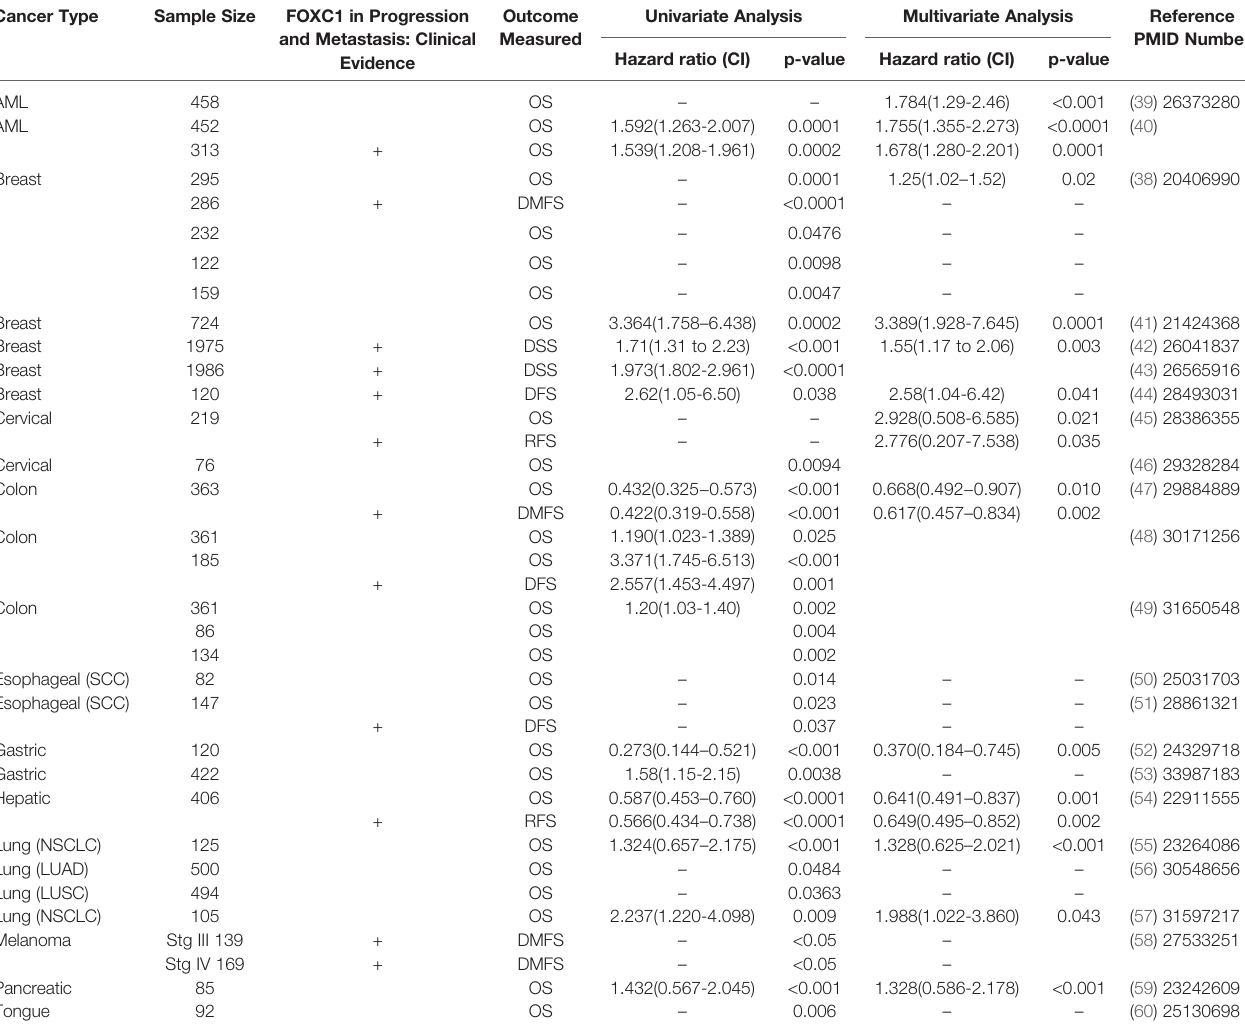
TABLE 1 | Clinical evidence supporting the role of FOXC1 in cancer progression and